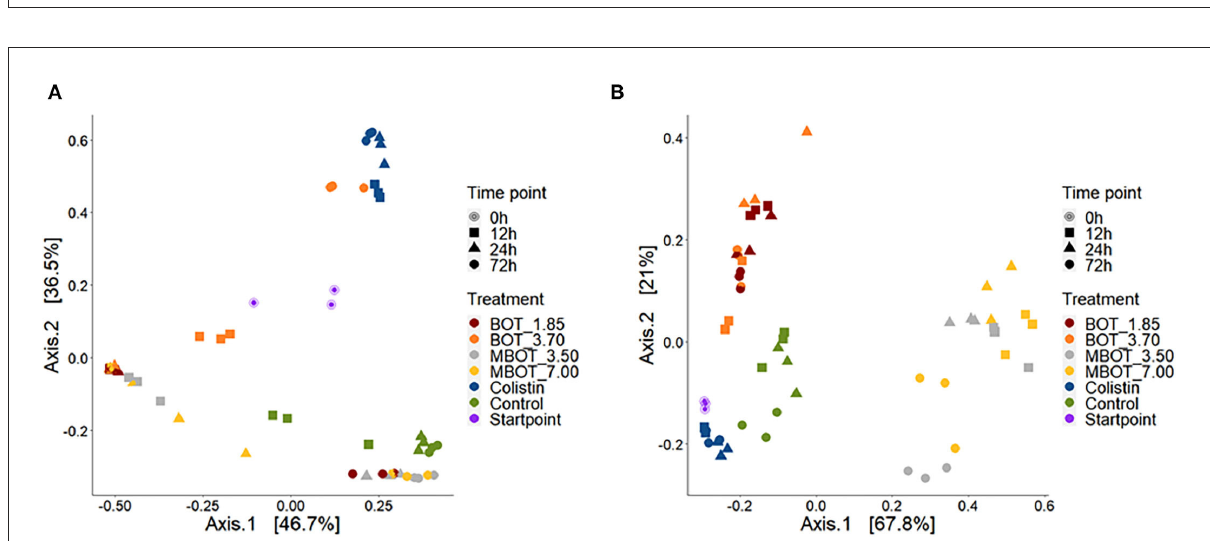
FIGURE3 PCoA plots based on weighted UniFrac dissimilarities of the microbial composition of pig ileum (A) and colon (B) fermentations as affected by unprotected BOT, microencapsulated BOT (MBOT) and colistin treatments and the time of fermentation. “Startpoint” of fermentation refers to the composition at 0h. Percentages at the axes indicate the amount of variation explained by the first two principal coordinates.